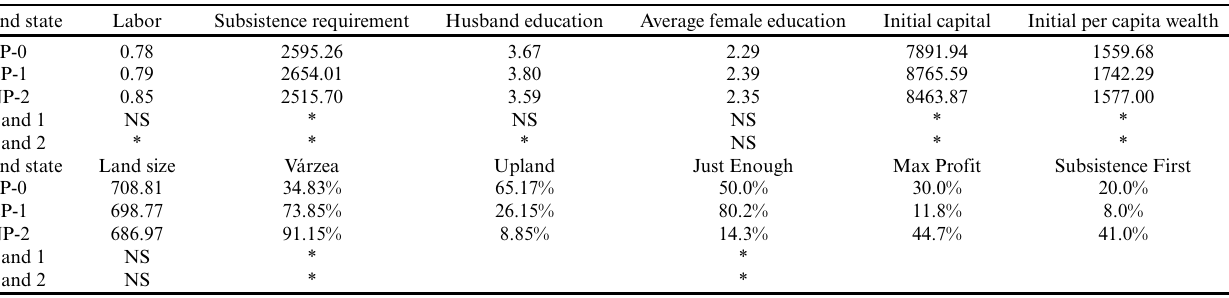
Table 6 . Comparing characteristics of chronic poor households in three livelihood states within shock scenarios. Note: EP = extreme poverty, CP = chronic poverty, and NP =